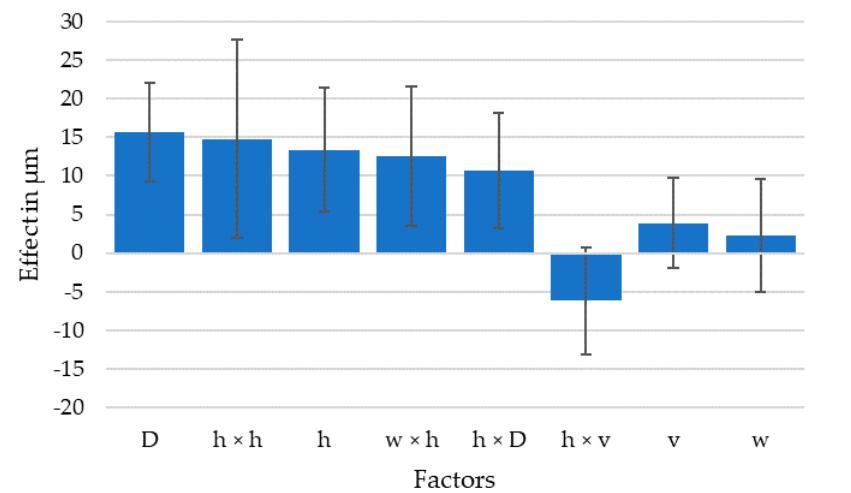
Figure 6. Effects of model parameters on surface roughness in descending order of magnitude for 95% confidence interval, Y axis is the effect on surface roughness if the parameter is varied between its upper and lower limit.